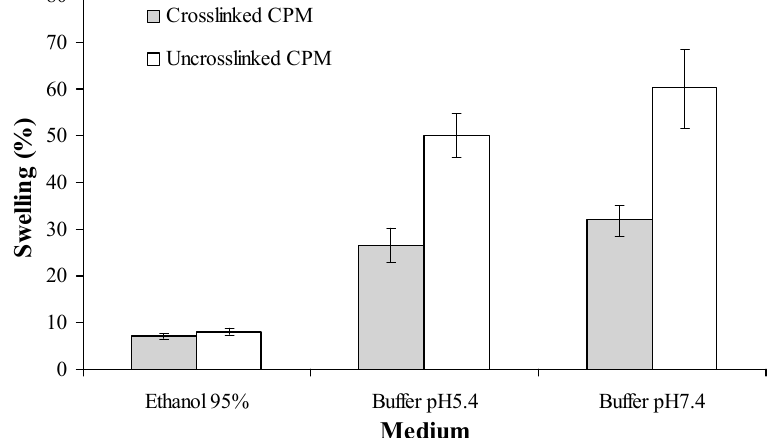
Figure 7. Swelling indexes of curcuminoids microcapsules in different media at 35 ± 2 °C. Mean ± standard deviation (SD), n = 3.